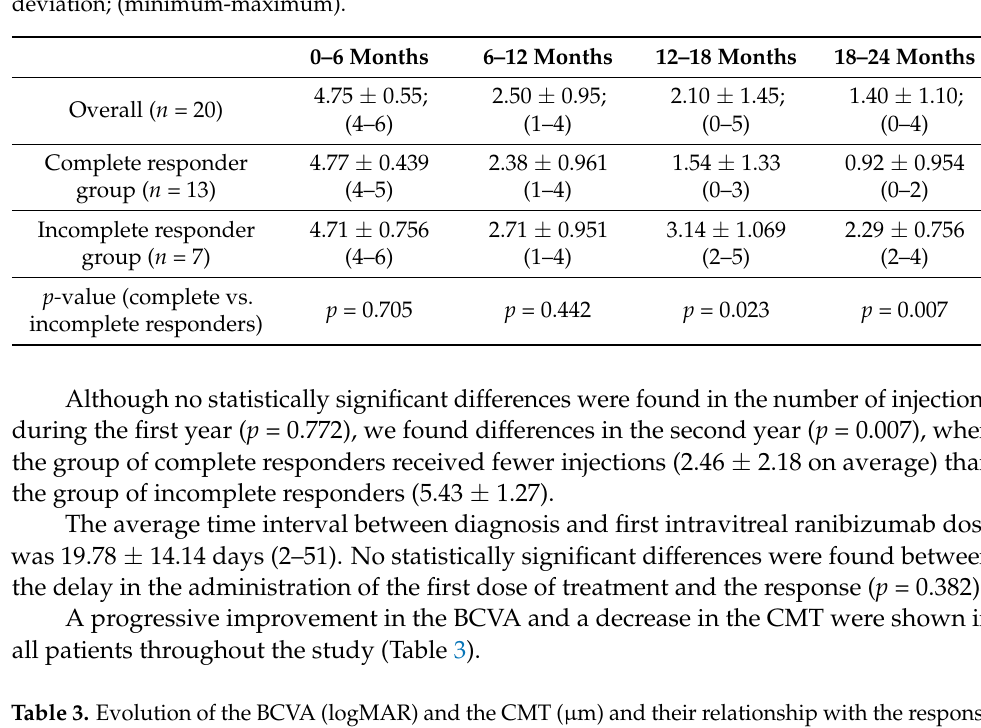
Table 3. Evolution of the BCVA (logMAR) and the CMT ( µ m) and their relationship with the response to treatment with ranibizumab, expressed as mean ± standard deviation; (minimum,